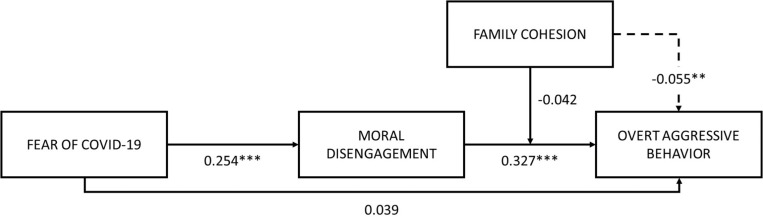
Model 1 Total sample on overt aggression behavior. RMSEA = 0.041, 90% CI [0.038, 0.044], CFI = 0.978, TLI = 0.973, SRMR = 0.039.